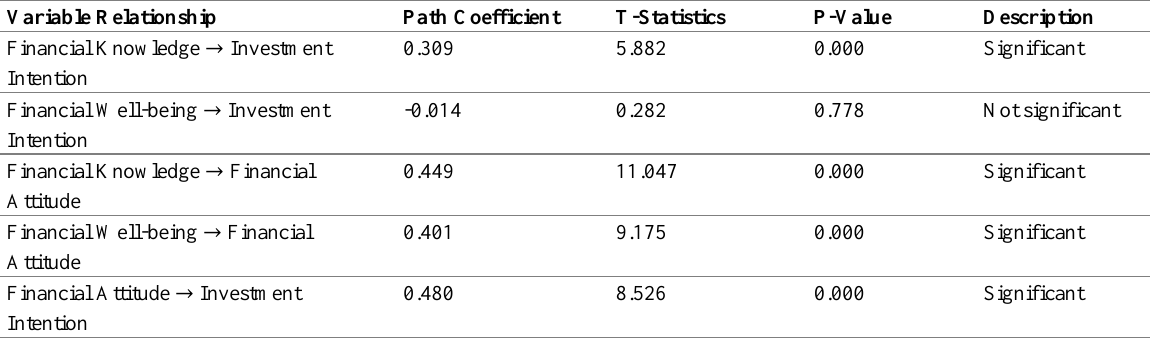
Table 5: Path Coefficient (cut off